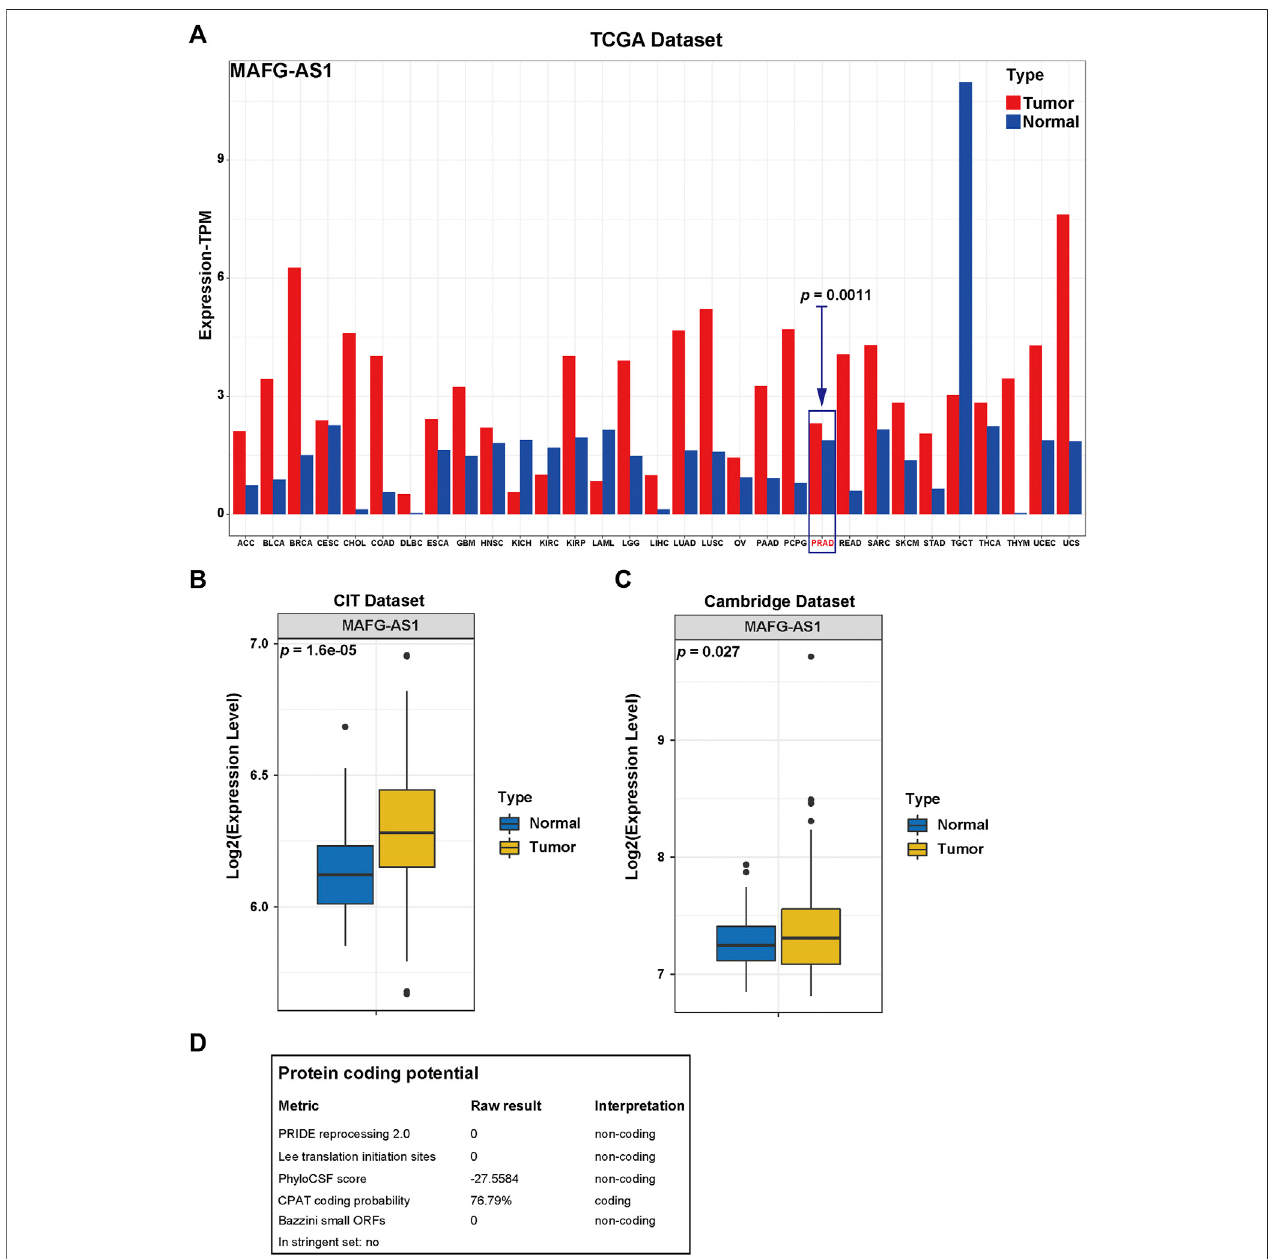
FIGURE 7 | Functional enrichment analysis of MAFG-AS1. (A) The pan-cancer expression pro fi le of MAFG-AS1 provided by the website tool, GEPIA2. (B, C) The MAFG-AS1 ’ s expression pro fi le in tumor tissue and adjacent normal tissue in two datasets, CIT dataset and Cambridge dataset. (D) The protein coding potential of MAFG-AS1 predicted by the website tool,